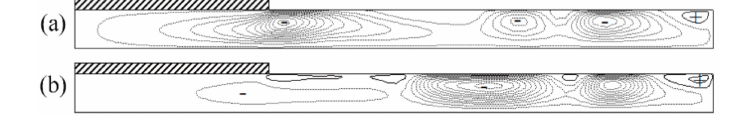
Figure 16. Streamlines on the R–Z plane when Re c is kept at 1871. ( a ) Re T = 5442; ( b ) Re T =